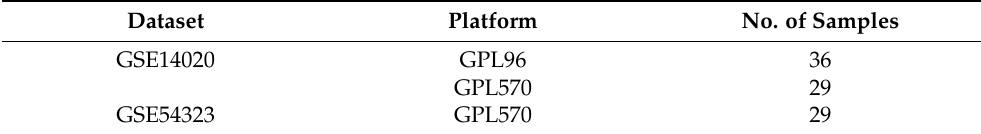
Table 1. Selected Data Sets and Number of Samples. Dataset Platform No. of